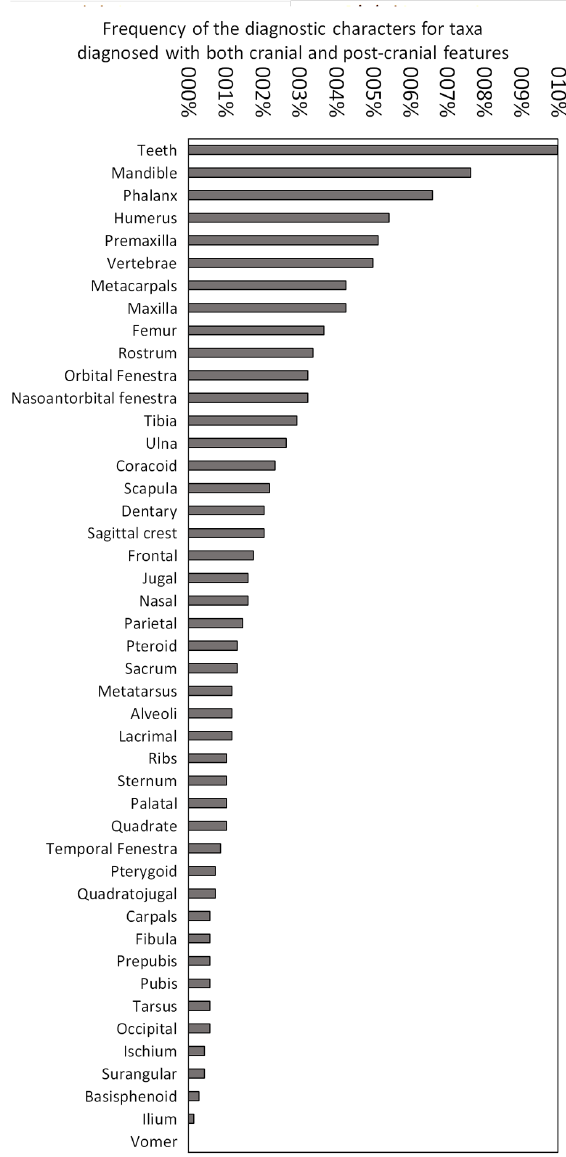
Figure 3. Frequency of cranial and post-cranial elements diagnosing new pterosaur